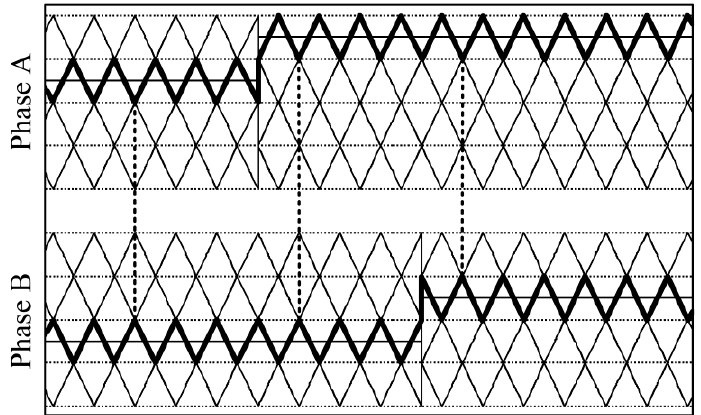
Figure 3. Phase deviation of equivalent carriers between ( phase A , B ) caused by the different initial position of references.